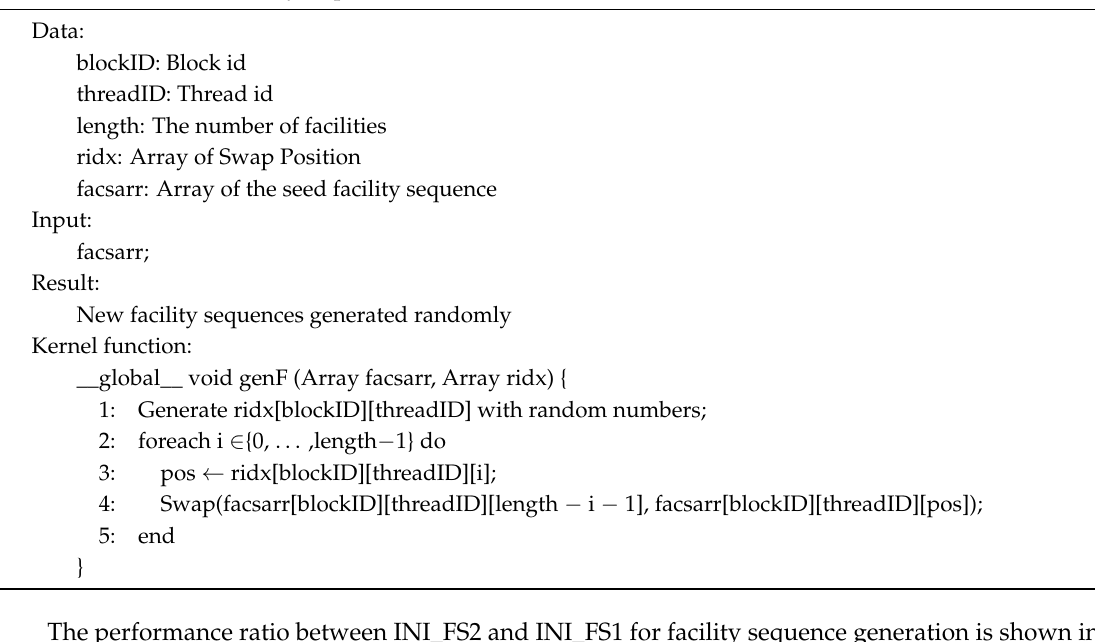
Algorithm 1: Parallel Facility Sequences Generation